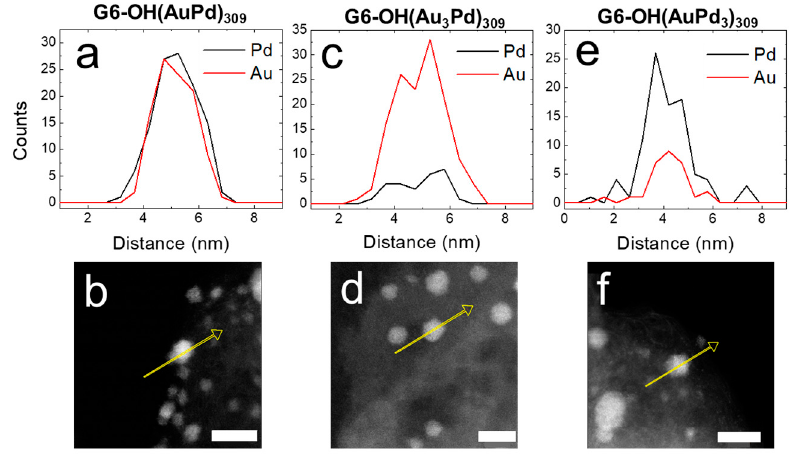
Figure 4. EDS line scans and corresponding ac ‐ STEM micrographs for conductive inks containing ( a , b ) G6 ‐ OH(AuPd) 309 ; ( c , d ) G6 ‐ OH(Au 3 Pd) 309 ; and ( e , f ) G6 ‐ OH(AuPd 3 ) 309 DENs following EOR CVs. The CVs were carried out at a scan rate of 50 mV/s in a N 2 ‐ satd., 1.0 M KOH solution containing 0.50 M ethanol. The yellow arrow on each ac ‐ STEM micrograph corresponds to the x ‐ axis of the EDS line scan. The scale bar is 5.0 nm.